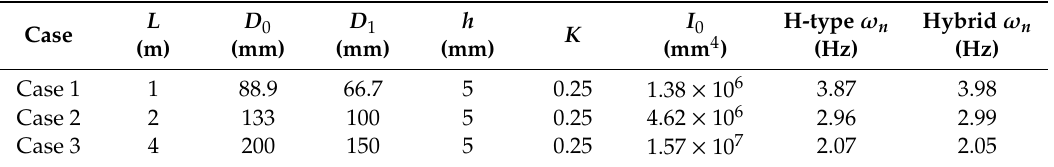
Table 3. Mast parameters of the SDOF model of the two VAWTs. Table 4. Natural frequencies of the SDOF model of the H-type and hybrid VAWTs with di ff erent mast